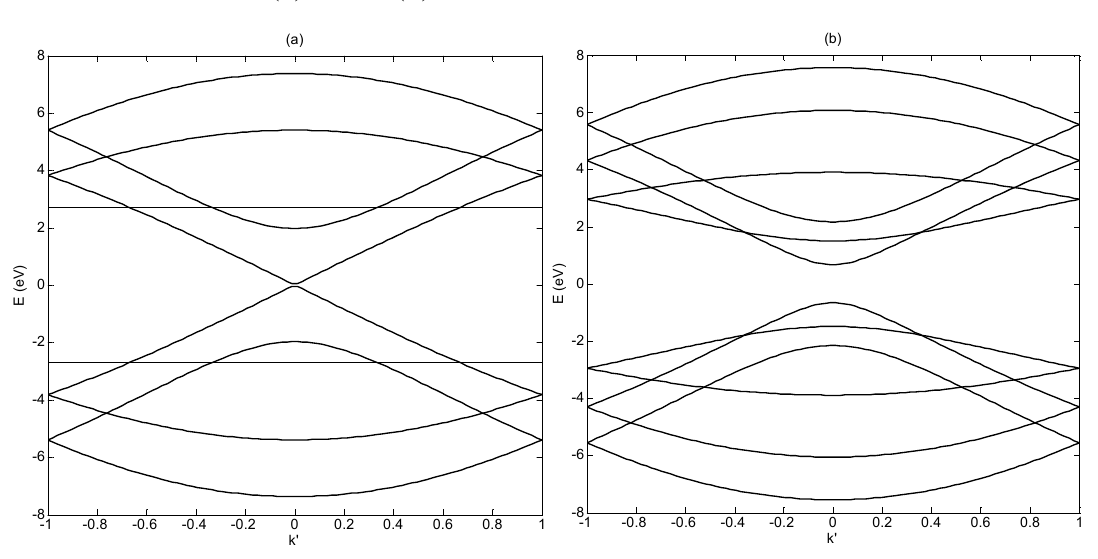
Figure 4. Energy band structure of an armchair nanoribbon versus the